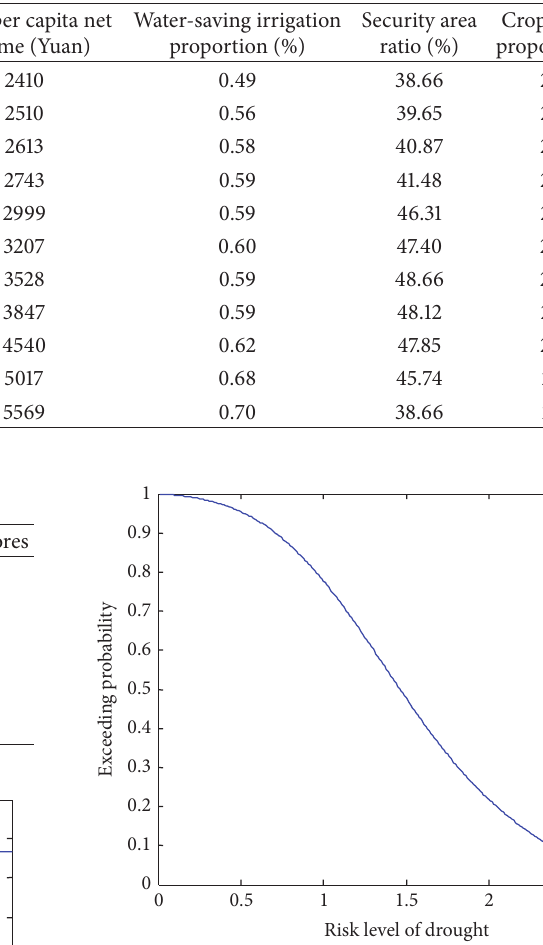
Table 1: Values of indicator system for drought risk evaluation in Qilin.